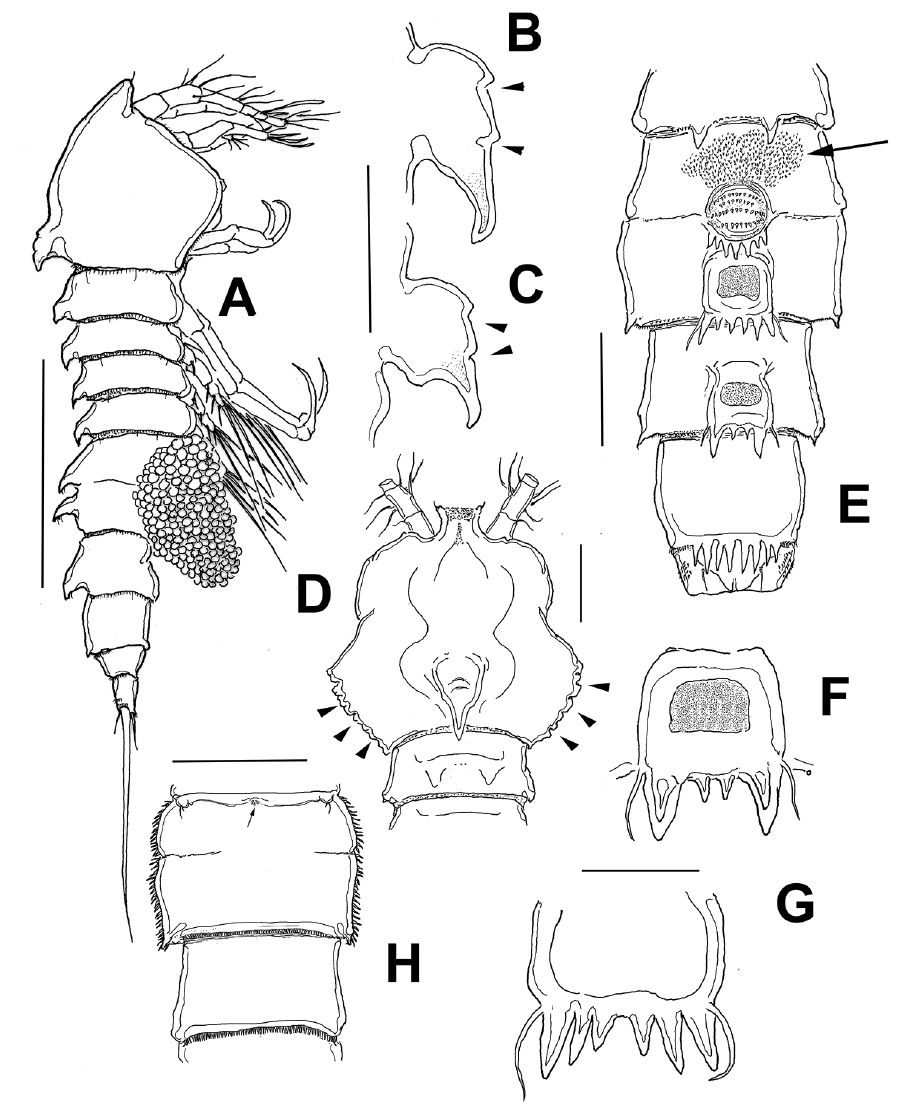
Figure 1. Echinolaophonte villabonae sp. n. , adult holotype female from Colombia. A habitus, lateral view B cephalosome dorsal process, lateral view, arrows indicate notches C same, another specimen D cephalo- some showing cuticular indentations on posterolateral margin (arrows), dorsal view E genital double, post- genital and preanal somites, dorsal view F detail of dorsal process on post-genital double-somite G detail of dorsal process, posterior genital double-somite H genital double-somite, ventral view showing sixth legs and genital pore (arrowed) on medial anterior margin. Scale bars: 200 μm( A ); 5 μm ( B–G